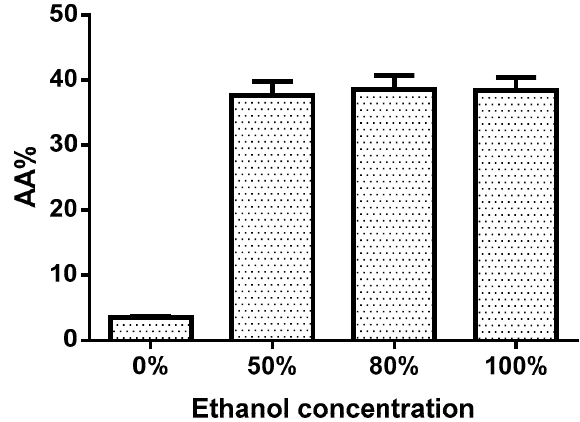
Figure 4. Antioxidant activity percentage. Individual samples of B . x buttiana extract ethanol 0%, 50%, 80%, and 100% were investigated to determine the antioxidant activity as described in Materials and Methods. Quercetin was used as reference antioxidants. Each bar corresponds to the results (mean ± standard deviation (SD)) from three different preparations.